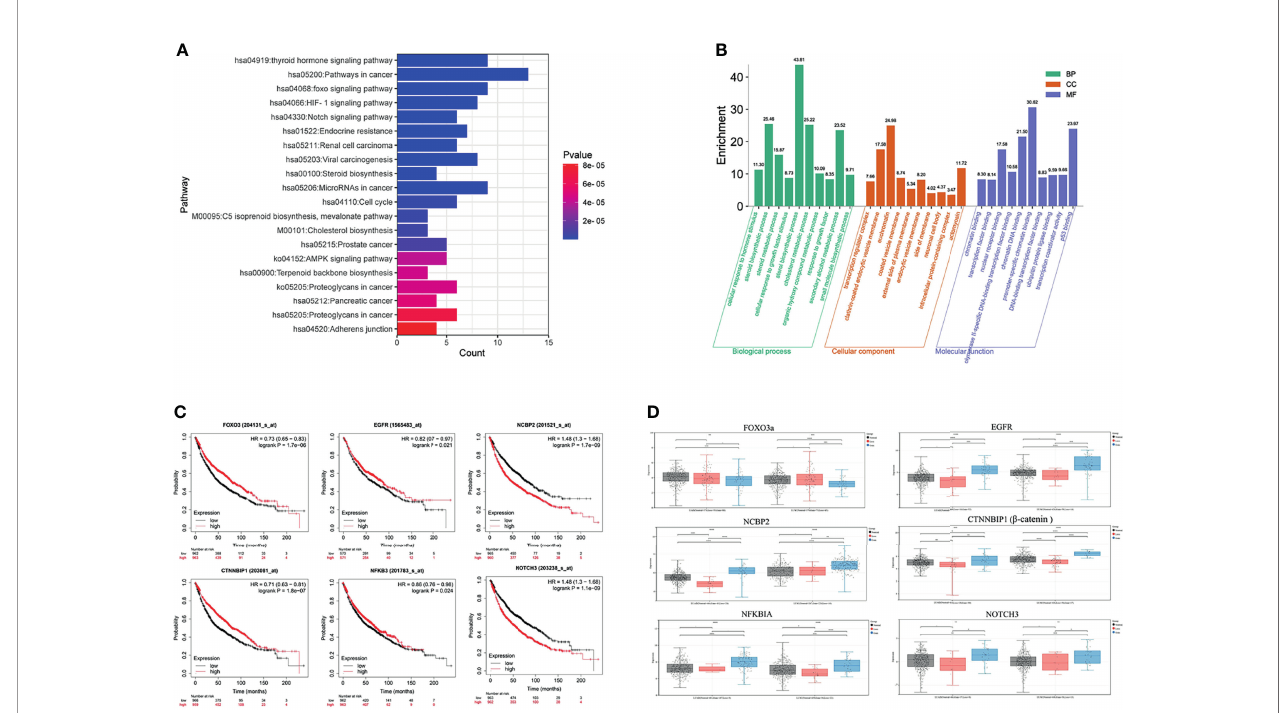
FIGURE 6 | Function and pathway enrichment analysis and key gene cluster. (A) KEGG enrichment analysis. (B) GO enrichment analysis. (C) Kaplan – Meier survival curves of six prognostic biomarkers screened from the hub gene. (D) Contrast of the expression of the six hub genes in the EGFR mutant LUAD and LUSC